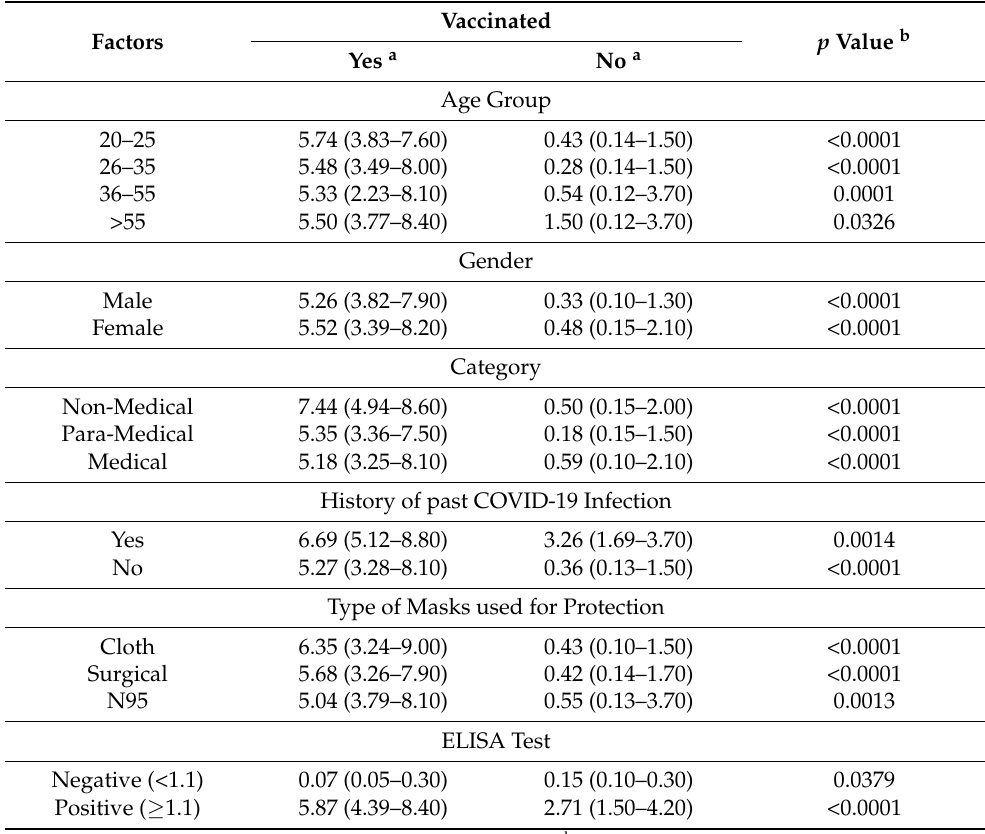
Table 2. Association of demographic and clinical characteristics of vaccinated and unvaccinated individuals with a COVID-19 IgG ELISA